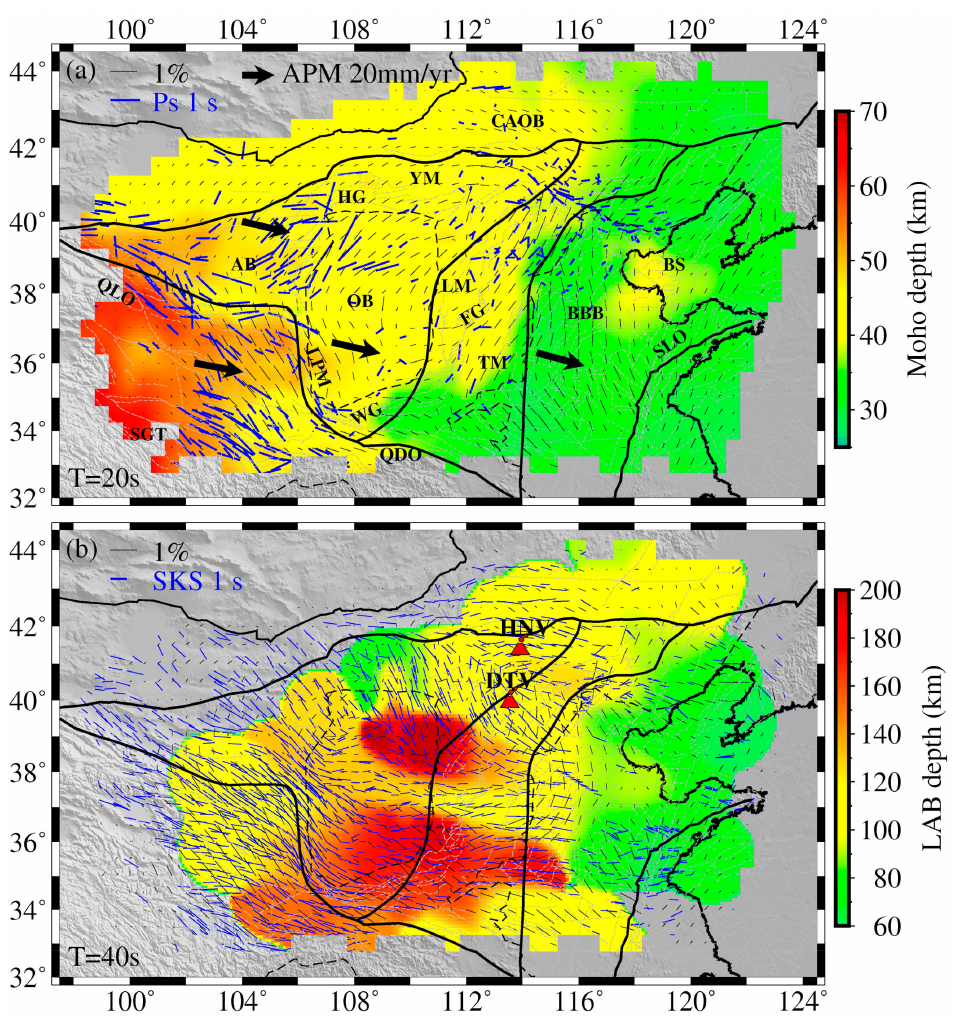
Figure 9. Azimuthal anisotropy of Rayleigh wave at period 20 s vs. the Ps phase splitting of receiver function [22,26,40] and at period 40 s vs. the SKS/SKKS phases splitting [24,38] ( a ) Distribution of Moho depth (after Li et al. [50] and Xu et al. [22,40]). The black arrows indicate the absolute plate motion (APM) direction of the GSRMv2.1 model [39]. The abbreviations of geological units are defined in the caption of Figure 1. ( b ) Distribution of lithosphere–asthenosphere boundary depth (after Chen et al.